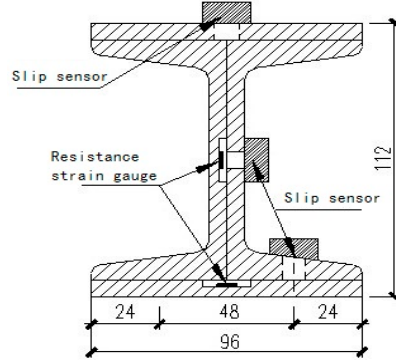
Figure 2. Section design of section steel.